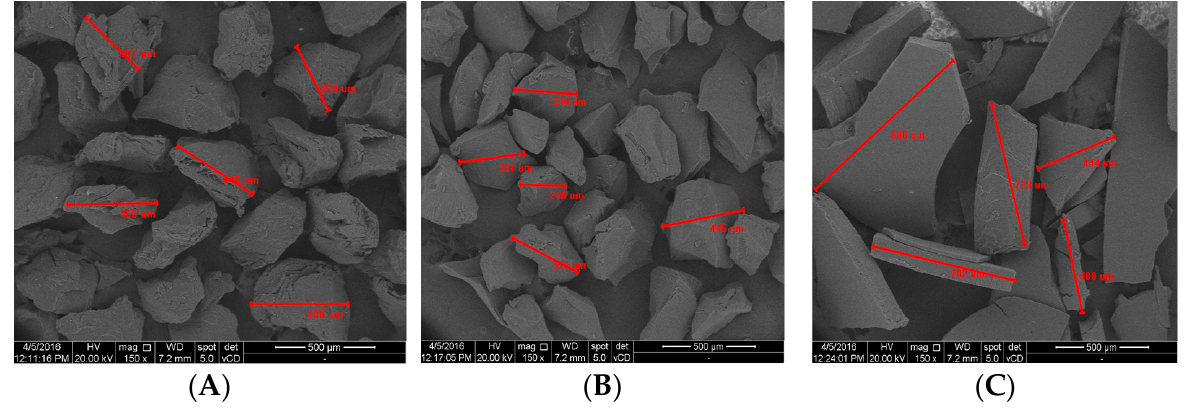
Figure 2. Microscopic structure of goatskin gelatin compared to porcine gelatin and bovine gelatin. ( A ) bovine gelatin; ( B ) porcine gelatin; ( C ) goatskin gelatin.